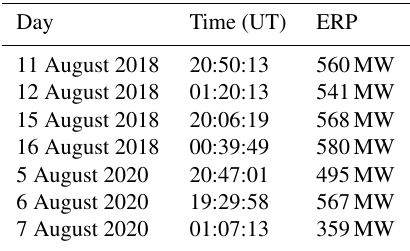
Table A2. Values of ERP given in the EISCAT heating facility logs from sample beam patterns for each of the measurements for reference. It seems that on 6 August 2020 at around 23:08:25UT three transmitters changed phases such that the beam became broader, with about 360MW X-mode and 17MW O-mode, which remained so until the end, which is why we have 359MW X-mode at 01:07:13UT (7 of